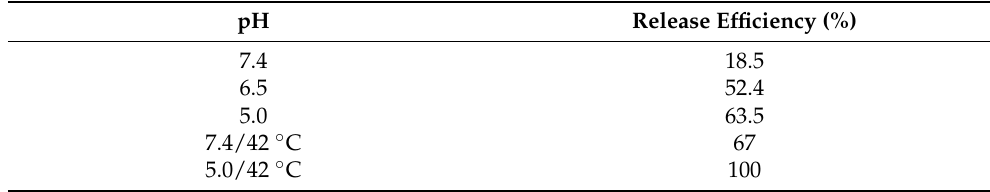
Table 2. Dox release efficiency from the MS@Dox/PNIPAm-PAAm system at different pH